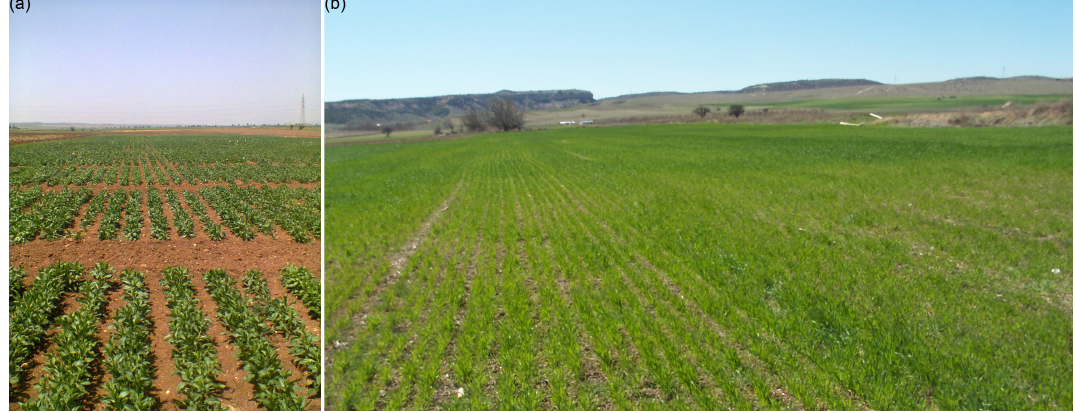
variations (%) W Test